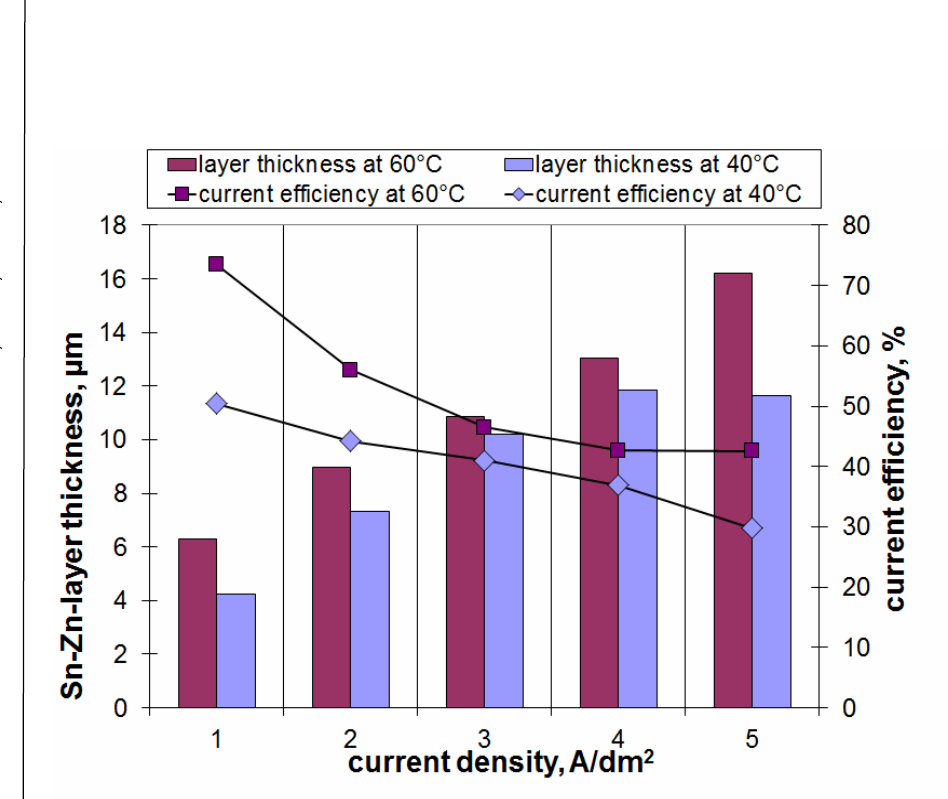
Рис . 7 – Эффективность катодного тока и толщина Sn-Zn слоя покрытия зависят от температуры и плотности тока ( электрохимическое осаждение из электролита 0.05 mol/l Sn; 0.1 mol/l Zn; 0.375 mol/l K4P2O7 с при применении 1g/l желатина ; pH = 9.3;1 A, 20 мин